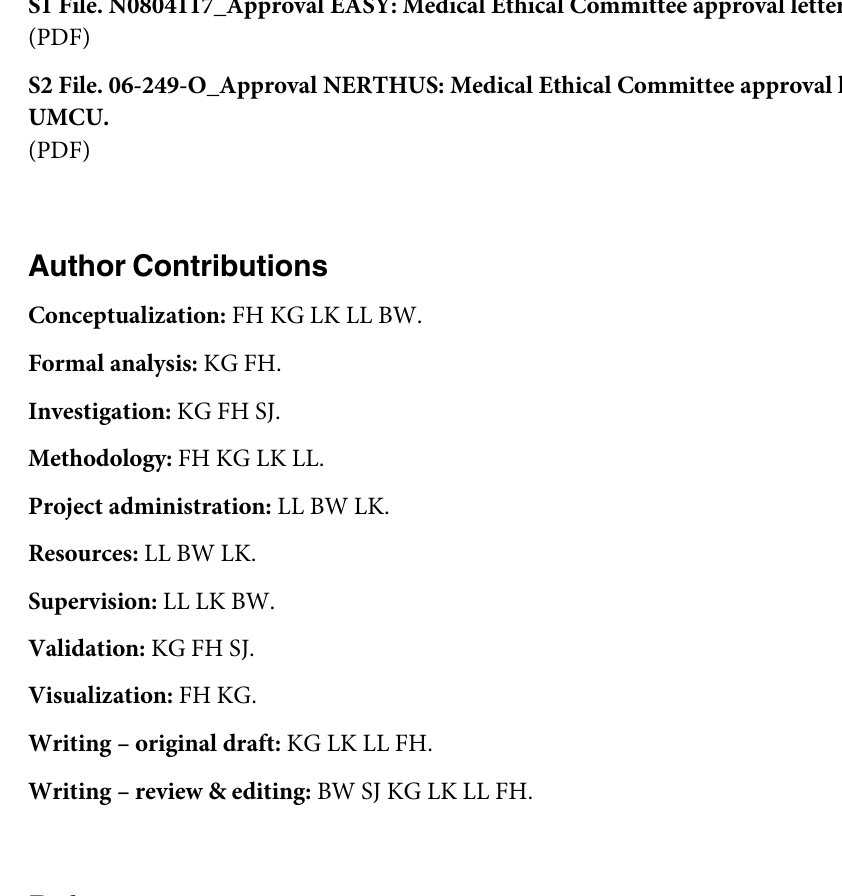
S1 Fig. Neutrophil parameters in relation to old sepsis definitions. Similar differences are seen for the old sepsis definitions between patient and control and between patients with and without septic shock, as compared with the new sepsis